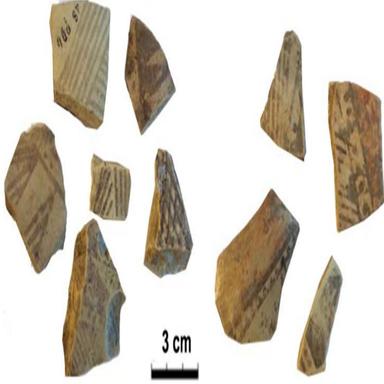
Some of the trichrome black and red painted wares samples from Ripoli village showing the peculiar decorations with red bands delimitated with black geometric lines or spots (the list of all the analyzed samples is reported in "supporting information"). (For interpretation of the references to color in this figure legend, the reader is referred to the web version of this article.)